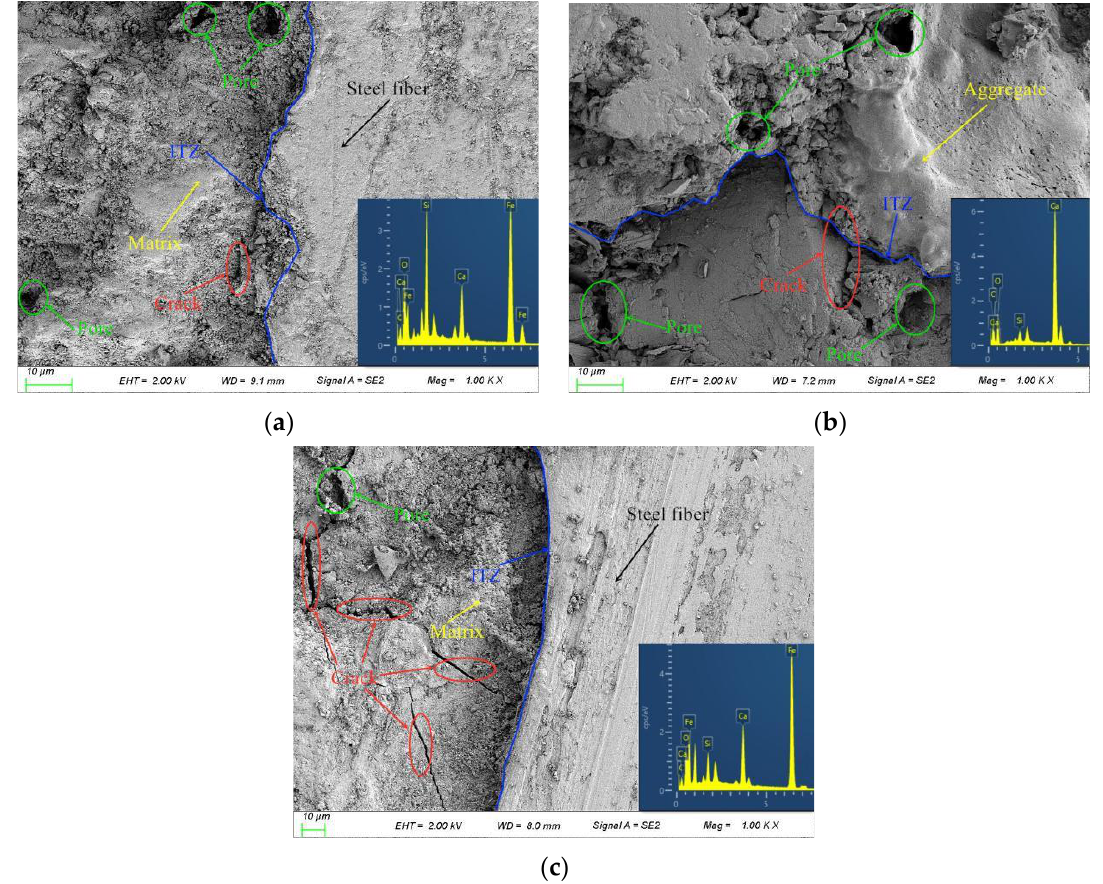
Figure 15. Morphologies of ITZs: ( a ) v sf = 1%; ( b ) v sf = 0%; ( c ) v sf = 2%. It can be seen that, as the distance from the surfaces of the SFs increases, the concentra- tion of Fe 2+ ions first decreases and subsequently increases. At 25–35 µ m from the surfaces of the SFs, the Fe 2+ ion concentration is close to the lowest value. After 40 µ m, the Fe 2+ ion concentration begins to level off, and at 100 µ m, it is the inherent Fe 2+ ion concentration of the cement itself. The results show that a part of the Fe 2+ ions can be dissolved from the surfaces of the SFs, which is different from an ordinary aggregate interface. This part of the Fe 2+ ions enters the water film, and the superposition of the ions dissolved in the cement and the ions dissolved from the SFs makes the concentration of ions in the interface higher than that in the ordinary aggregate interface. Fe 2+ ions can reduce some of the adverse effects of the water film, and more CSH is formed close to the SFs. This increases the probability of the CSH contacting the SFs and causes it to fill the porous structure close to the surface of the SFs, therefore enhancing the compactness of the structure. The Fe 2+ ion concentration is lower in the A area slightly further from the fiber surface, and the needle-shaped AFt and hexagonal-shaped CH mainly accumulated in the area. Owing to the influence of solid particle shape, the sparse accumulation of particles around the side wall produces numerous pores, resulting in the formation of a loose structure in the ITZ around the aggregates, which can be considered to be a weaker area in the SF–matrix. However, excessive SFs can have a detrimental effect on the concrete, which requires a more detailed analysis of the microscopic pore structure